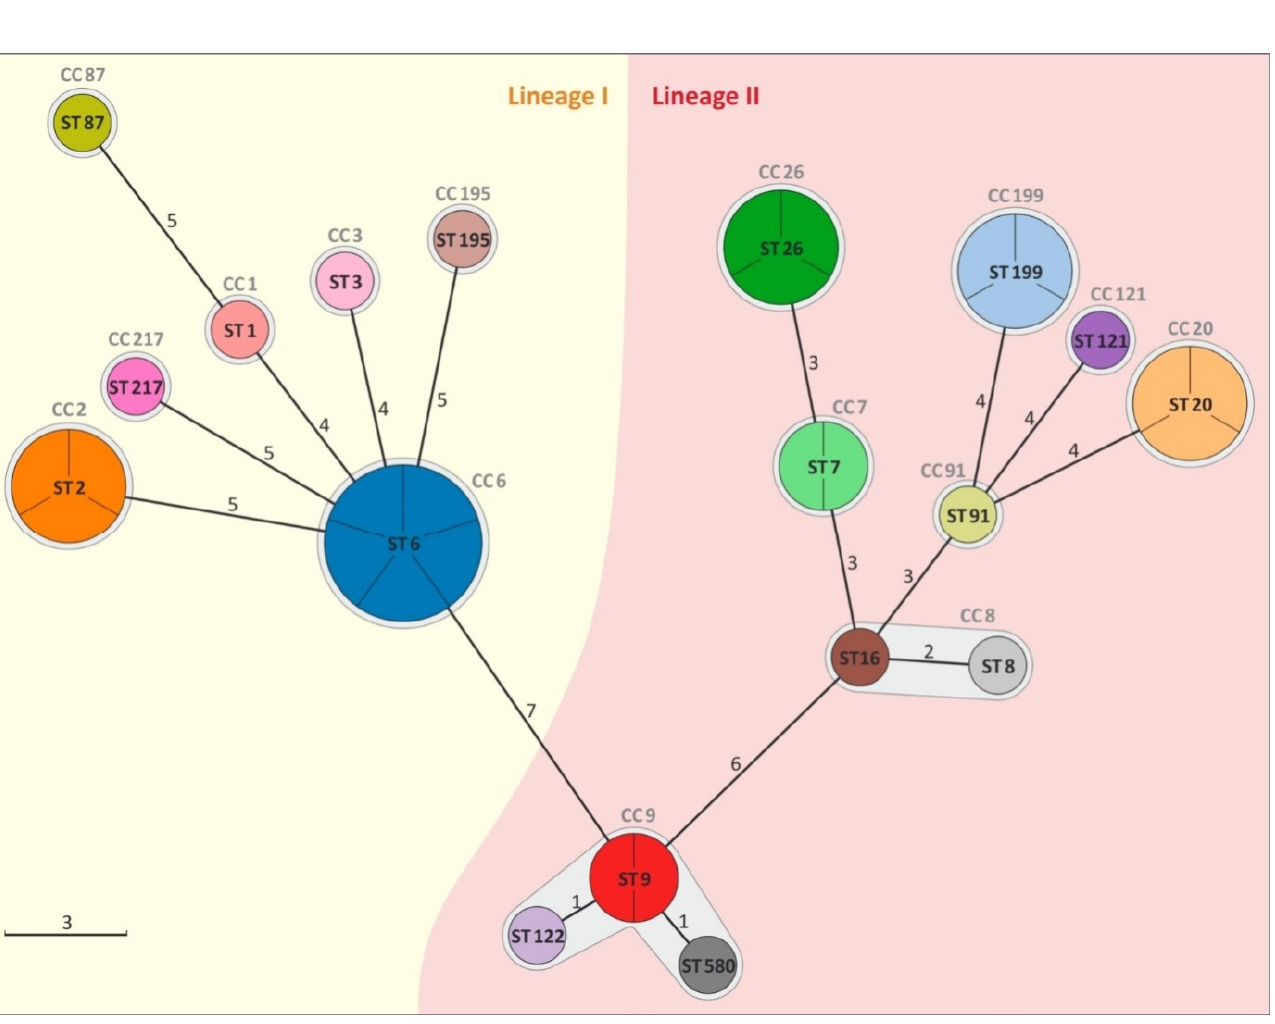
Figure 1. Minimum spanning tree (MST) illustrating the phylogenetic relationship based on sequence types (STs) allelic profiles of L. monocytogenes isolates. Each circle represents one ST. The size of the circle is proportional to the number of isolates. The fragment of the circle corresponds to single isolates. Links between the circles are represented according to the number of allelic mismatch between STs.